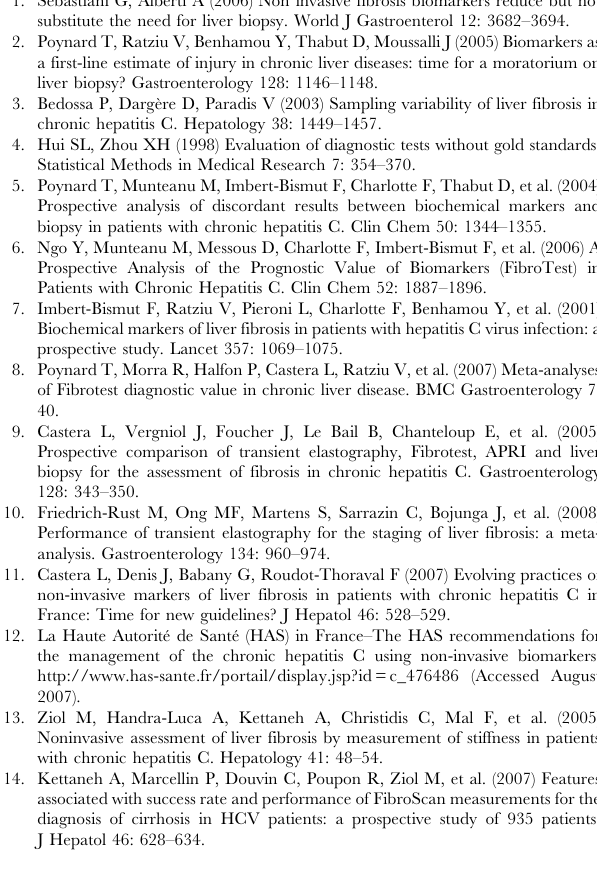
Table S6 Sensitivity analysis